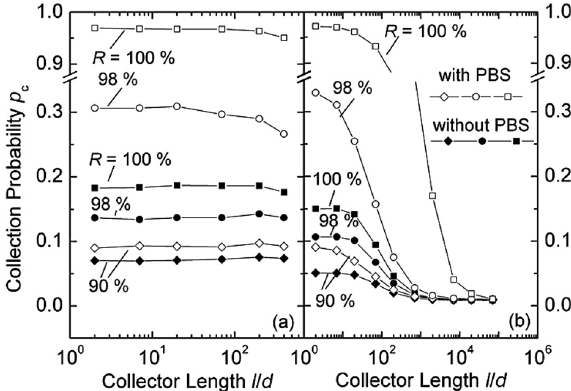
Fig. 9. Influence of non-perfect mirror at the back side of the FC in systems with a coverage fraction f = 0 . 01. (a) Side-mounted solar cells. Inclusion of non-radiative losses in the dye decreases the photon collection significantly. The rela- tive deterioration in a system with applied PBS is higher than in the system without PBS. (b) Bottom-mounted solar cells. At small l/d the system shows a similar behavior as the side- mounted